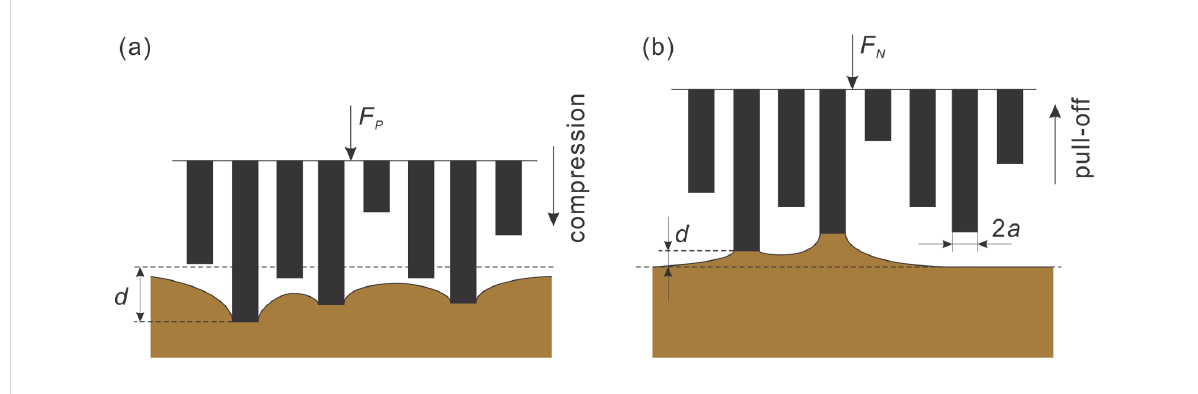
Figure 2: The scheme of indenting and pull-off stages of an adhesive contact of exponentially distributed pillars.